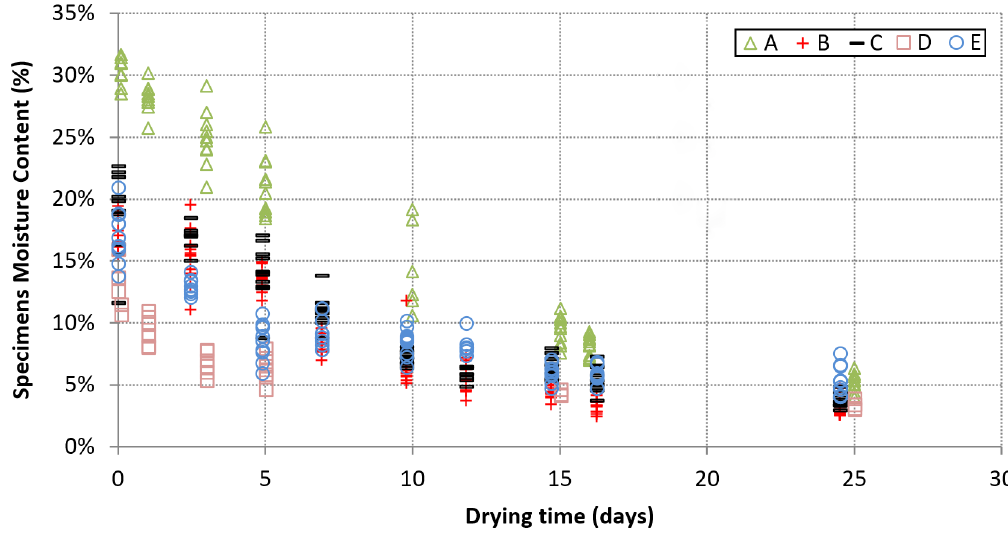
Figure 4. Moisture variation versus drying time after the 10 day immersion